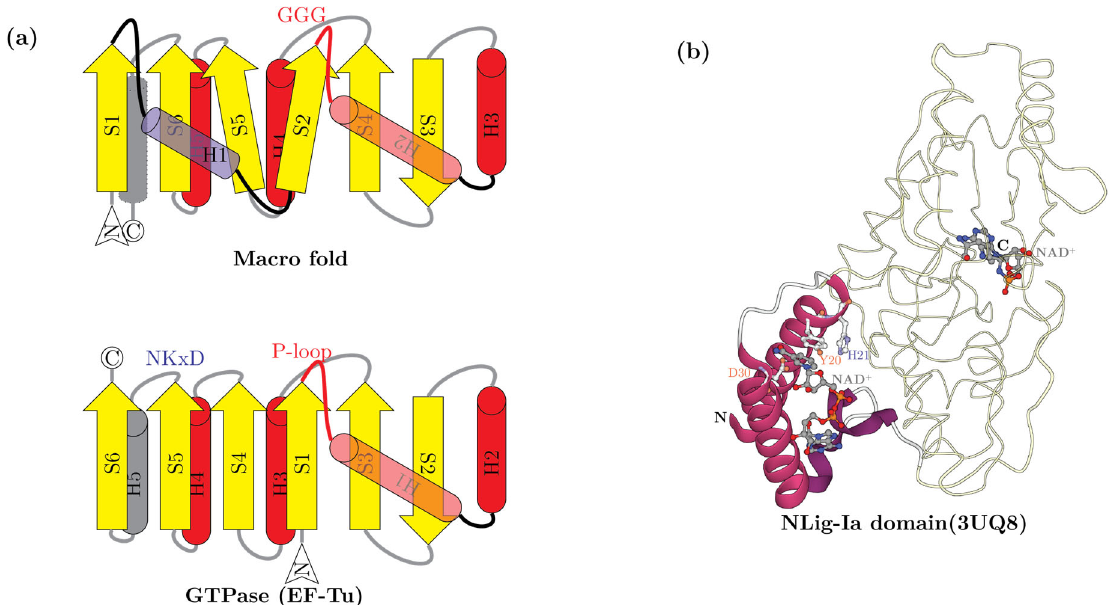
Figure 4. ( a ) Topology diagram of the core of the Macro domain and the EF-Tu-like GTPases illustrating their structural relationship. Strands labeled with an ‘S’ prefix followed by their order number in the core structure are shown as yellow arrows, whereas helices which are similarly labeled with a ‘H’ prefix are shown as red cylinders. ( b ) The structure of the Nlig-Ia domain (cartoon rendering) that exists as a solo domain only in viruses. The figure illustrates the residues involved in binding NAD + and its relative position with respect to the C-terminal ATP-grasp and RAGNYA domain of the NAD + ‐ dependent ligases (rendered as a tube).